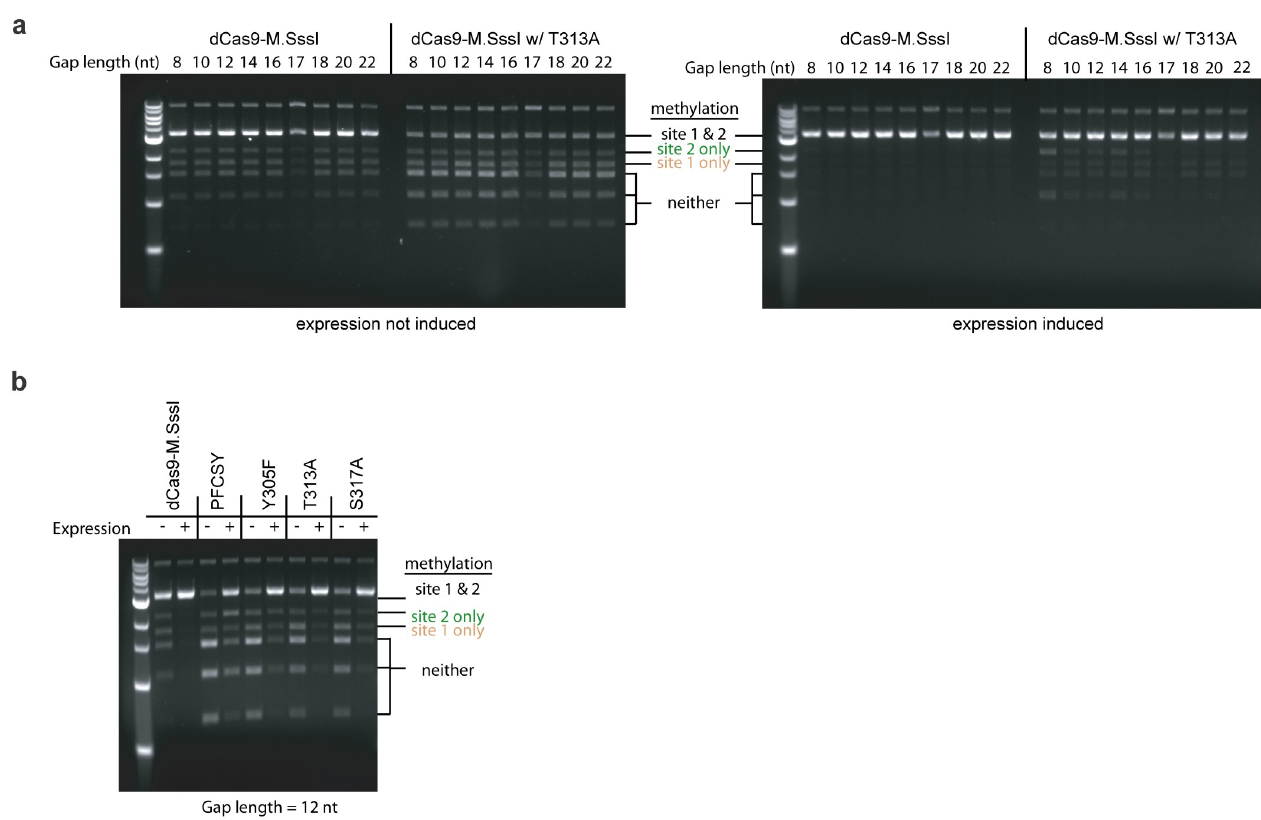
Fig 10. Methylation as caused by dCas9-M.SssI and associated mutants as assessed by the restriction enzyme protection assay. Methylation pattern as a function of mutation and induction of expression (a) as a function of the distance away from the PAM (8–22 bp) with and without the T313A mutation and (b) at a distance of 12 bp away from the PAM for several different mutations. Methylation was assayed from isolated plasmid DNA from ER2267 cells grown in lysogenic broth with 0.2% glucose and either with (+) or without (–) 0.0167% arabinose for induction of expression of dCas9-M.SssI variants under the pBAD promoter. Methylation was assayed as described in Fig 1. The size of diagnostic bands for methylation is different than in Fig 1 since MN has been deleted from pReporter (dCas9-M.SssI is expressed from pEncode). sgRNA1 was used to target site